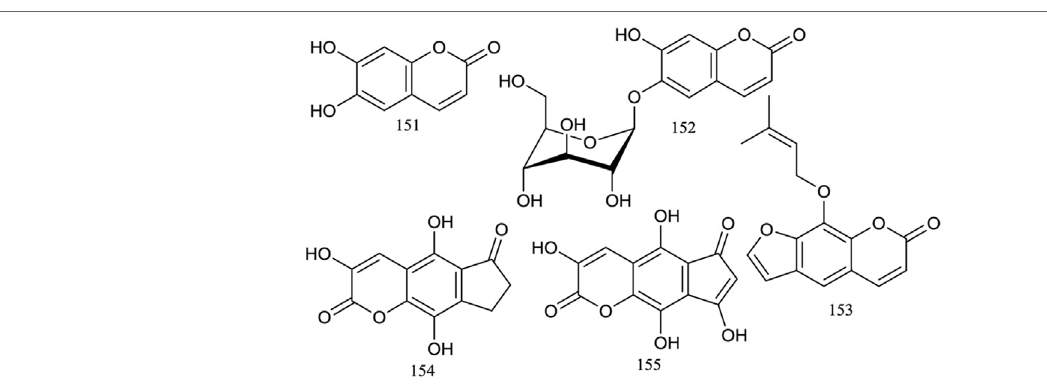
FIGURE 6 | Chemical structures of coumarins (151–155) isolated from R. chingii